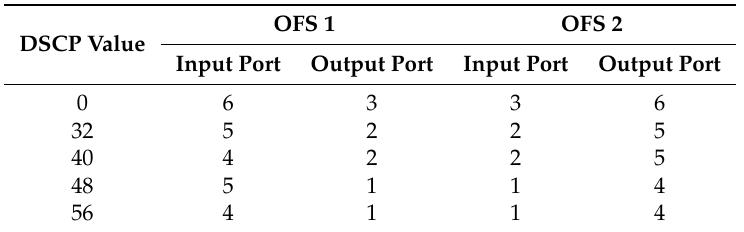
Figure 9. The number of received IP packets for each DSCP value on Ethernet ports 1, 2, and 3 of network tester 2. Table 2. Flow tables of OpenFlow switch (OFS) 1 and OFS